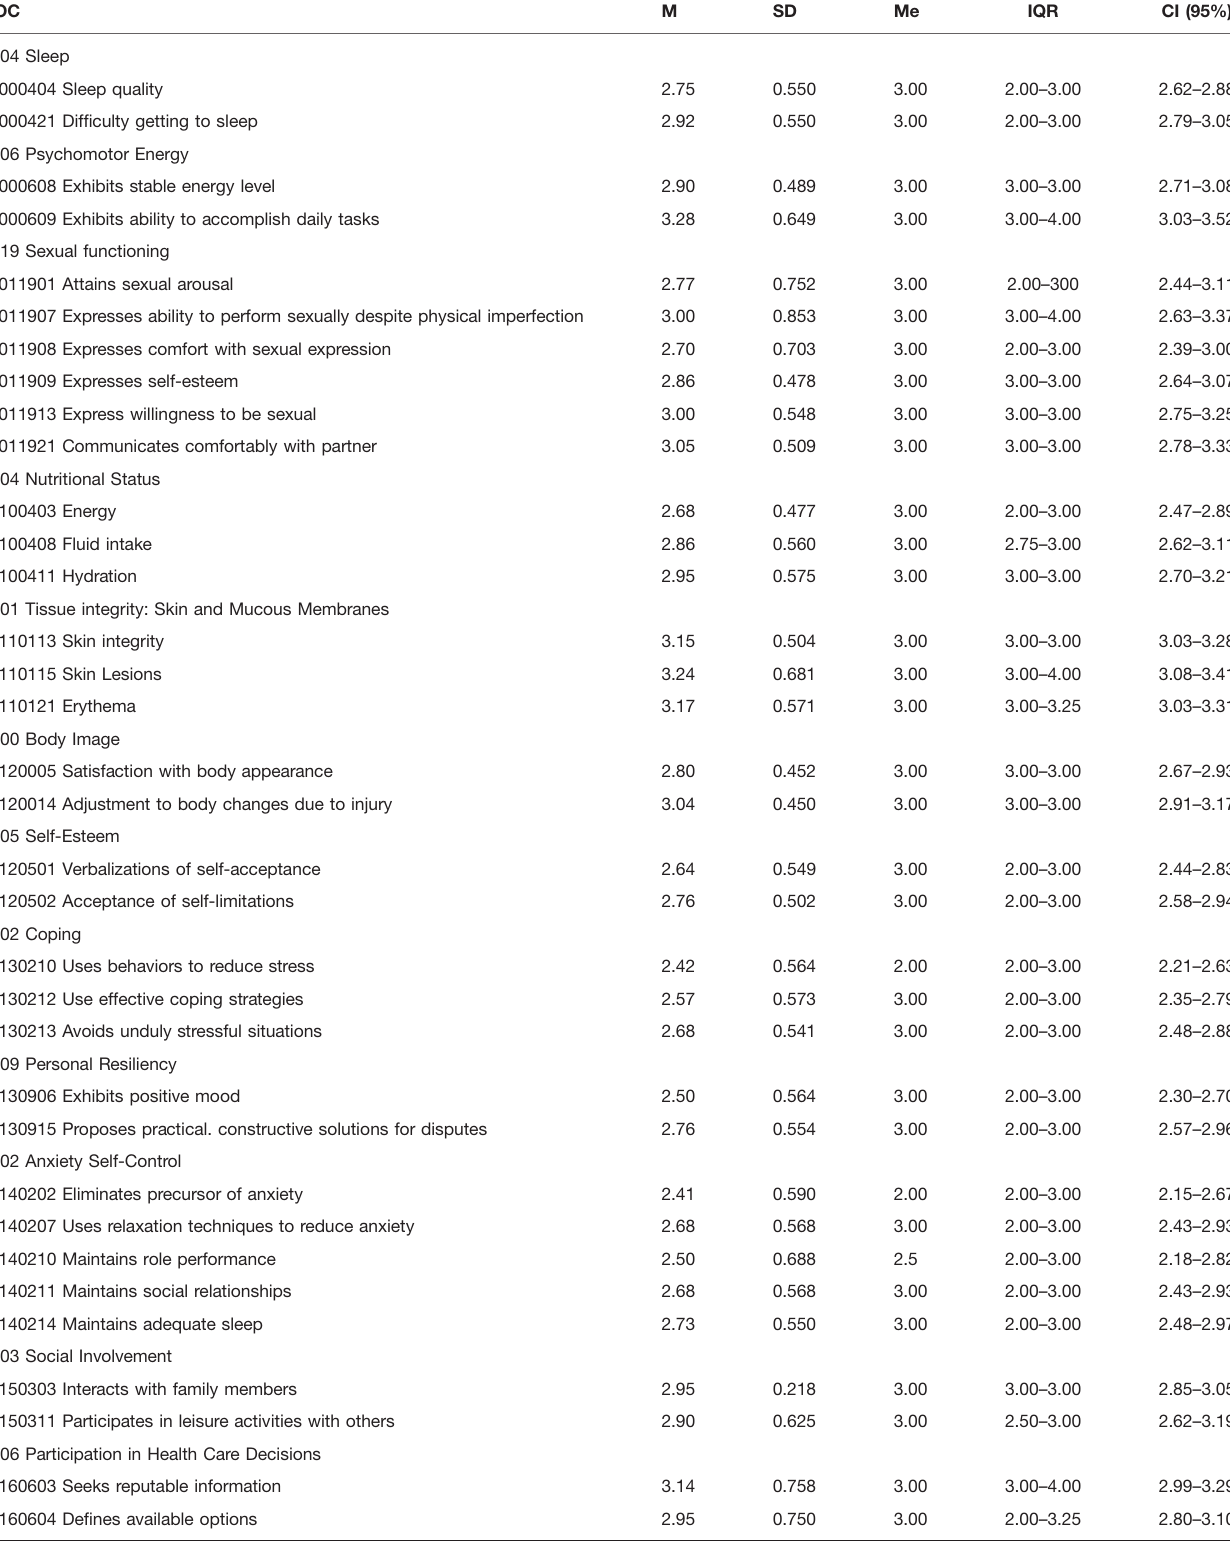
TABLE 4 | Descriptive analysis of NOC outcomes with 20 or more